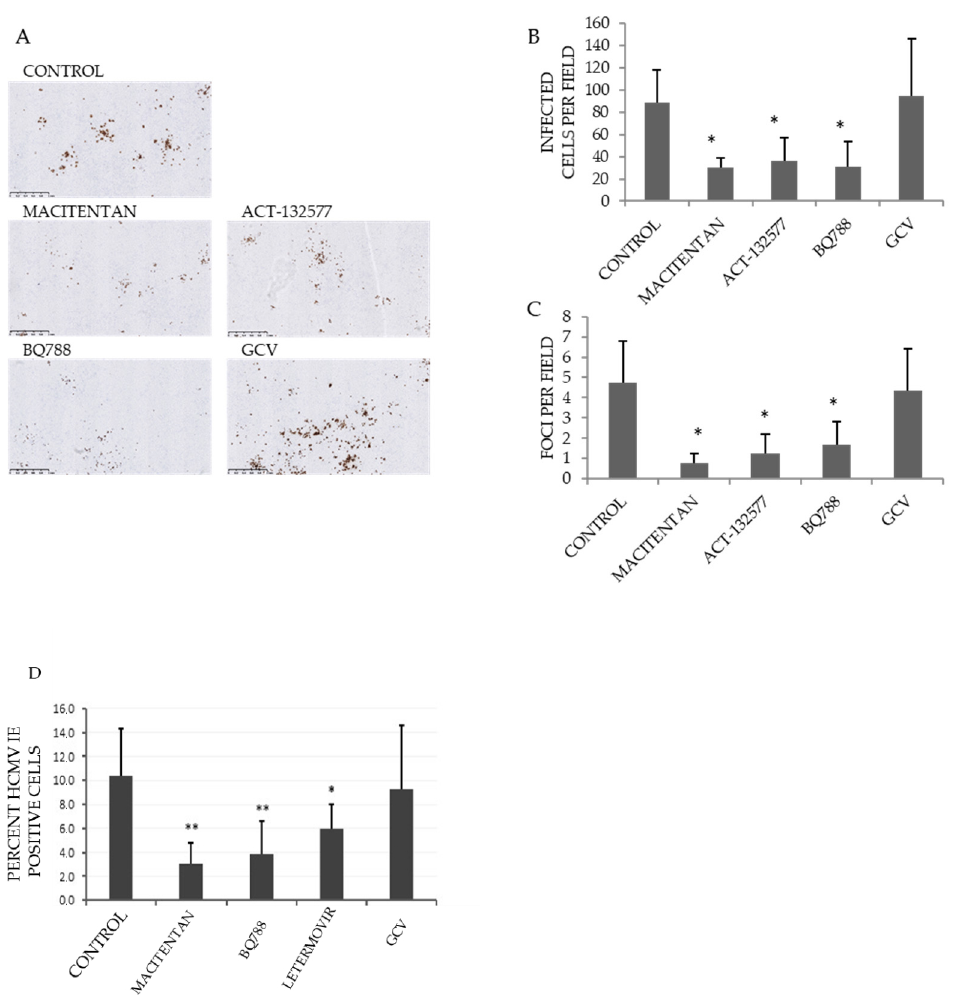
Figure 5. Decreased HCMV-IE positive cells in cultures treated with macitentan, its metabolite ATC- 132577 and BQ788. HUVECs were treated with ETR antagonists (12.5 µM) and exposed to MRC5s infected with the ganciclovir-resistant HCMV clinical isolate C17222. Seven days later, IE expression was assessed by immunostaining. ( A ) Representative images. Brown stain corresponds to IE immu- noreactivity and represent HCMV positive cells. ( B ) The number of IE-immunopositive cells per field of view was quantified. ( C ) The number of IE-positive foci (comprising more than 3 IE-positive cells) per field of view was quantified. ( D ) HUVEC cells were infected by exposing them to C17222 infected MRC5s (HUVEC: infected MRC5 ratio of 1:1) and treated or not with 10 µM of ganciclovir, 10 µM of letermovir, 100 µM of BQ788 or 25 µM of macitentan. At seven days post infection, the virus-containing cells were harvested and used to infect MRC5 cells. Percentage of positive IE stained cells was measured at 3 dpi. Values are mean ± SD of at least triplicate images. Asterisks (*) denote a statistically significant difference with respect to the control ( p- value < 0.05 and (**) a p- value < 0.01).